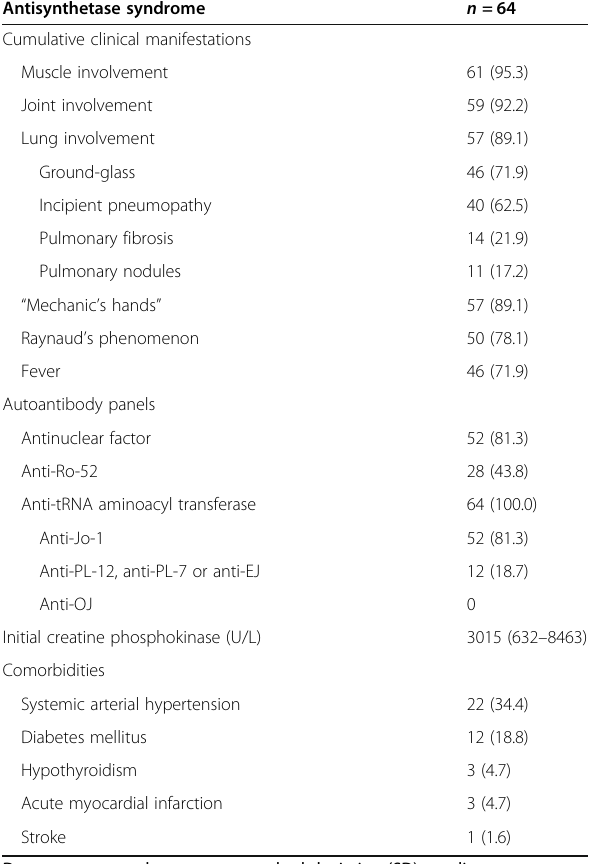
Table 1 Cumulative clinical manifestations, autoantibody panels, initial creatine phosphokinase serum levels, and comorbidities of the patients with antisynthetase